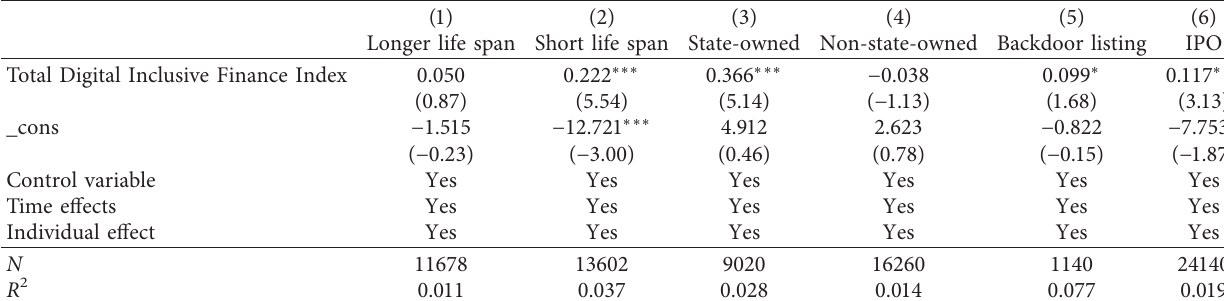
Table 7: Heterogeneity analysis.